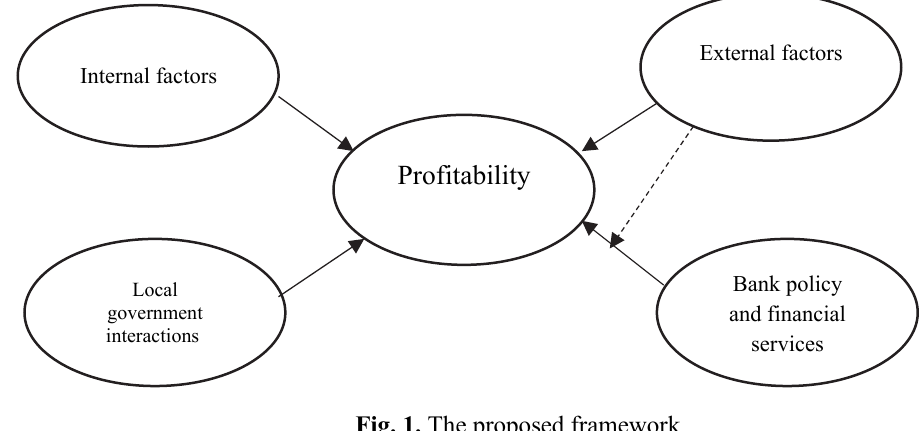
Fig. 1. The proposed